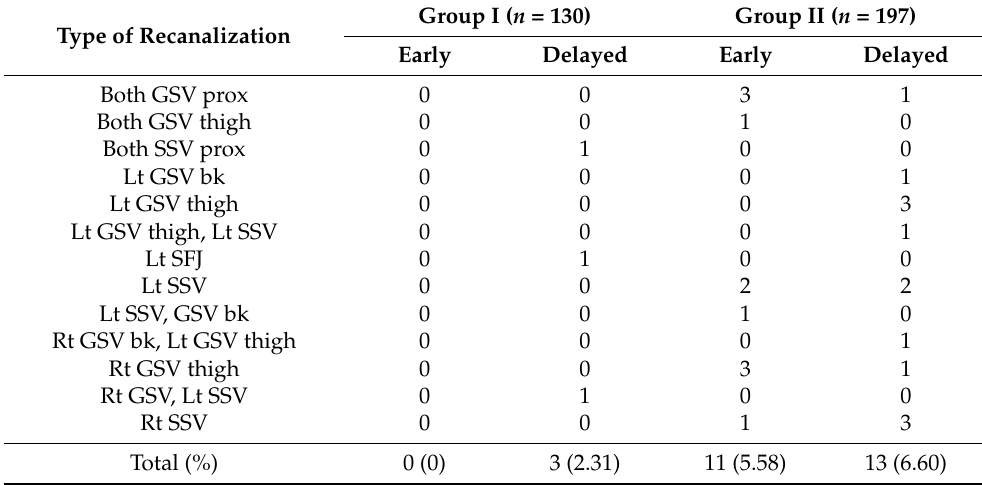
Table 6. Type of recanalization between MOCA (Group I) and combined EVLA and MOCA (Group II). Group I ( n = 130) Group II ( n = 197) Type of Recanalization Early Delayed Early Delayed Both GSV prox Both SSV